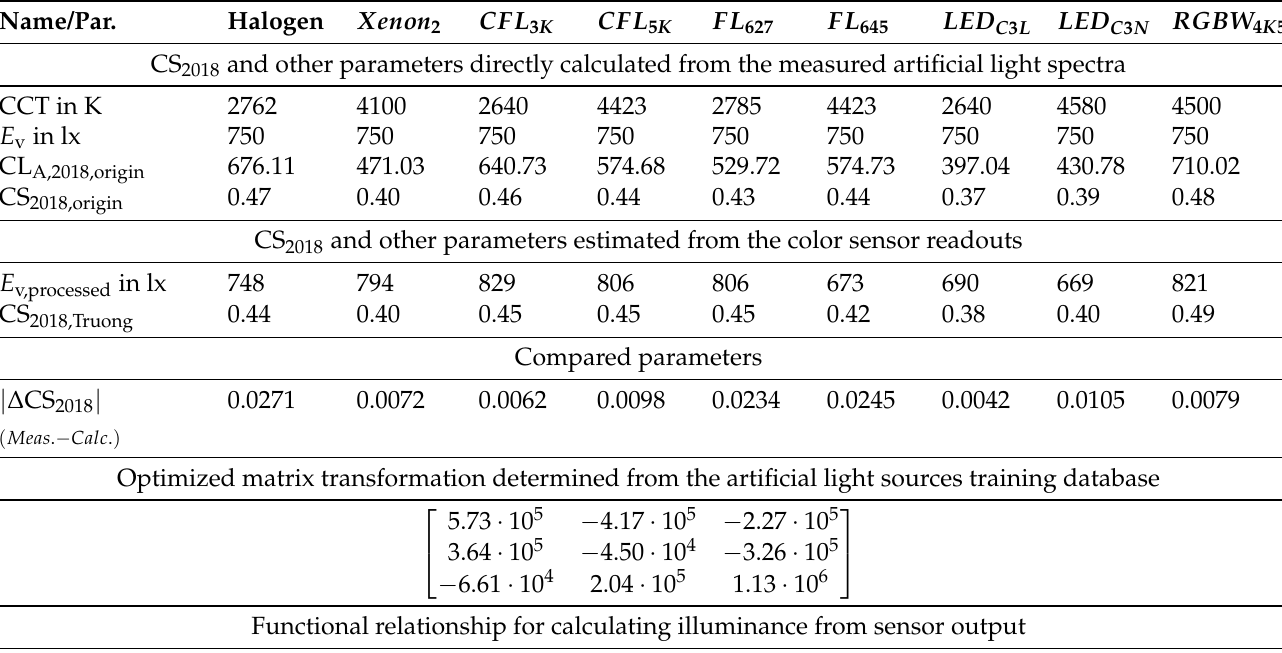
Table 3. Color sensor’s CS predictions obtained from applying Truong et al.’s approximation method to the transformed color sensor readouts (CS 2018,Truong ) in comparison to the CS predictions of Rea et al.’s original model (CS 2018,origin ) for a selection of artificial light sources from the training dataset at an assumed vertical illuminance of 750lx. The measurement accuracy for CS 2018,origin is of the order of ± 8% due to the measurement uncertainties of the used spectroradiometer. Additionally tabulated are the final 3 × 3 transformation matrix, as well as the functional relationship between the illumi- nance and the sensor’s green channel output G i . The annotation “ ( Meas . − Calc . ) ” in the “Compared parameters” section of the table serves as an indication that the accuracy estimate | ∆ CS 2018 | for a given light source is determined by the absolute difference between Rea et al.’s and Truong et al.’s cor- responding CS predictions as derived from the light source’s radiometric measurements (i.e., “ Meas .”) and calculated from the resulting sensor readouts (i.e., “ Calc .”),